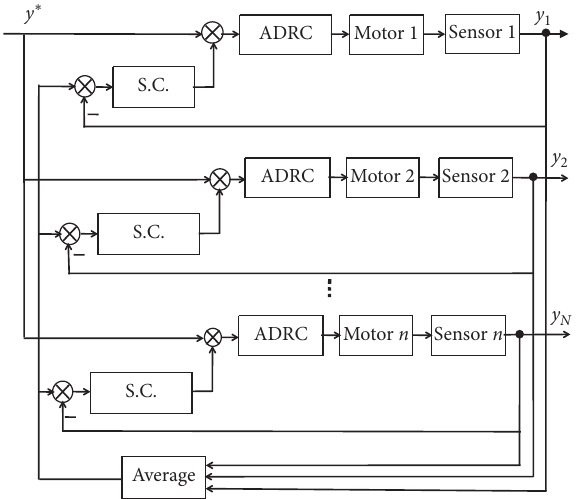
Figure 1: Deviation-coupling synchronization control